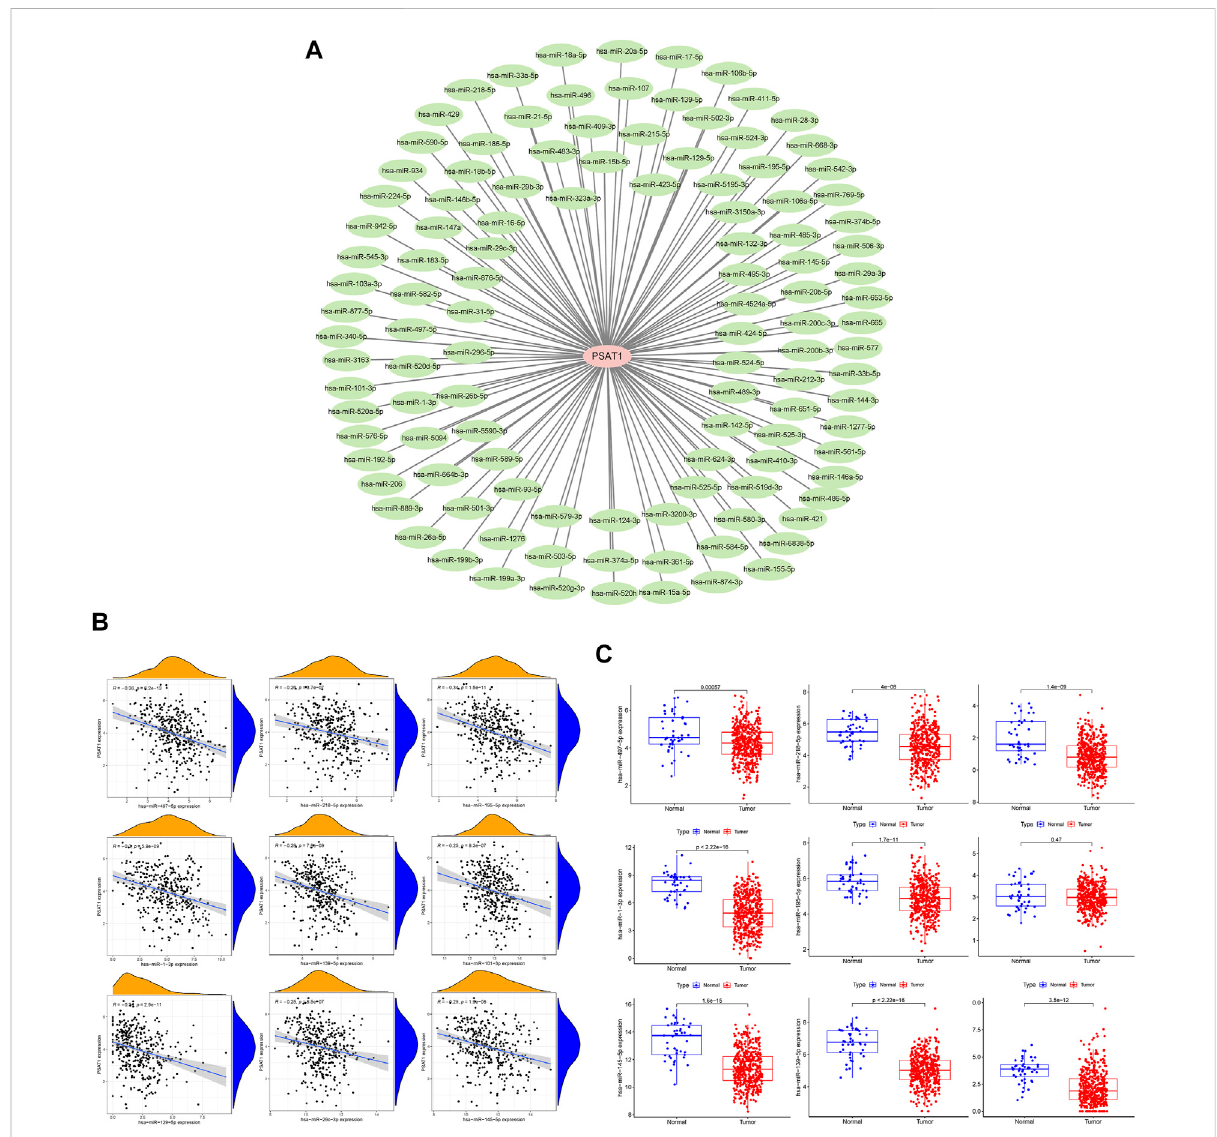
FIGURE 2 The microRNAs associated with gastric cancer expression of PSAT1. (A) . The miRwalk database and correlation analysis identi fi ed microRNAs that could target PSAT1 in gastric cancer; (B) . MicroRNAs negatively correlated with PSAT1 expression; (C) . Gastric tumor tissues and normal tissue samples showed negative correlations between miRNA levels and PSAT1 expression